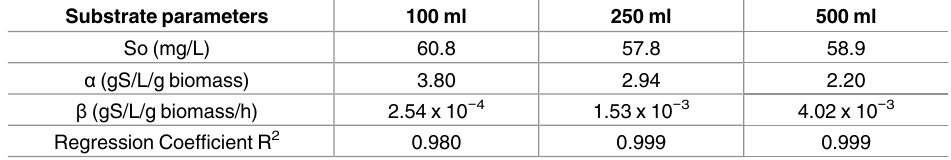
Table 5. Substrate parameters defining of the Leudiking and Piret model in shake cultures of L . theo- bromae strain 2334 in volumes of 100, 250 and 500 mL. Substrate